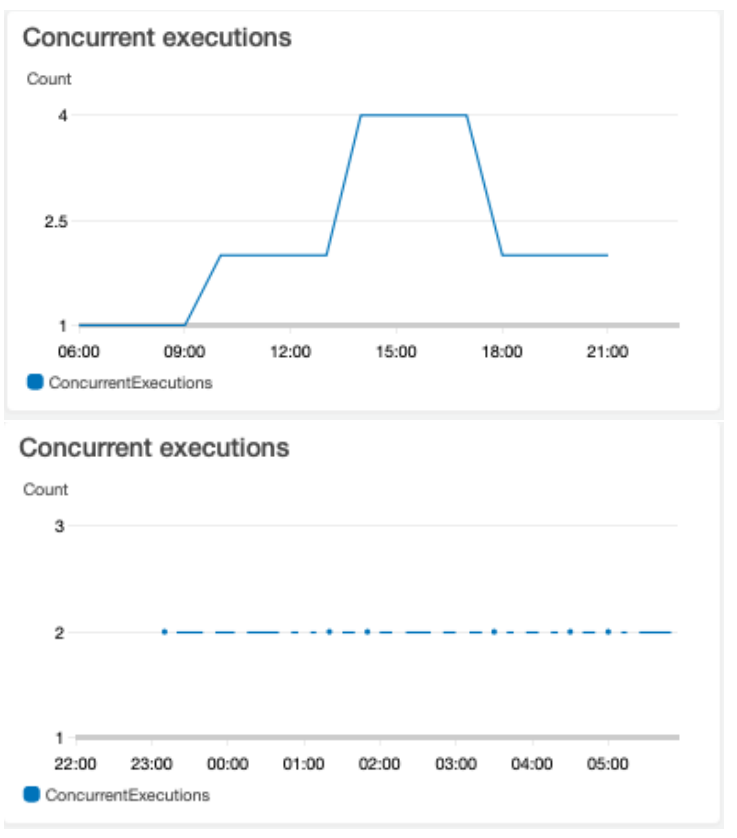
Figure 8. Concurrency Levels: (upper) Concurrency Interval 1–5; and (lower) Concurrency Interval